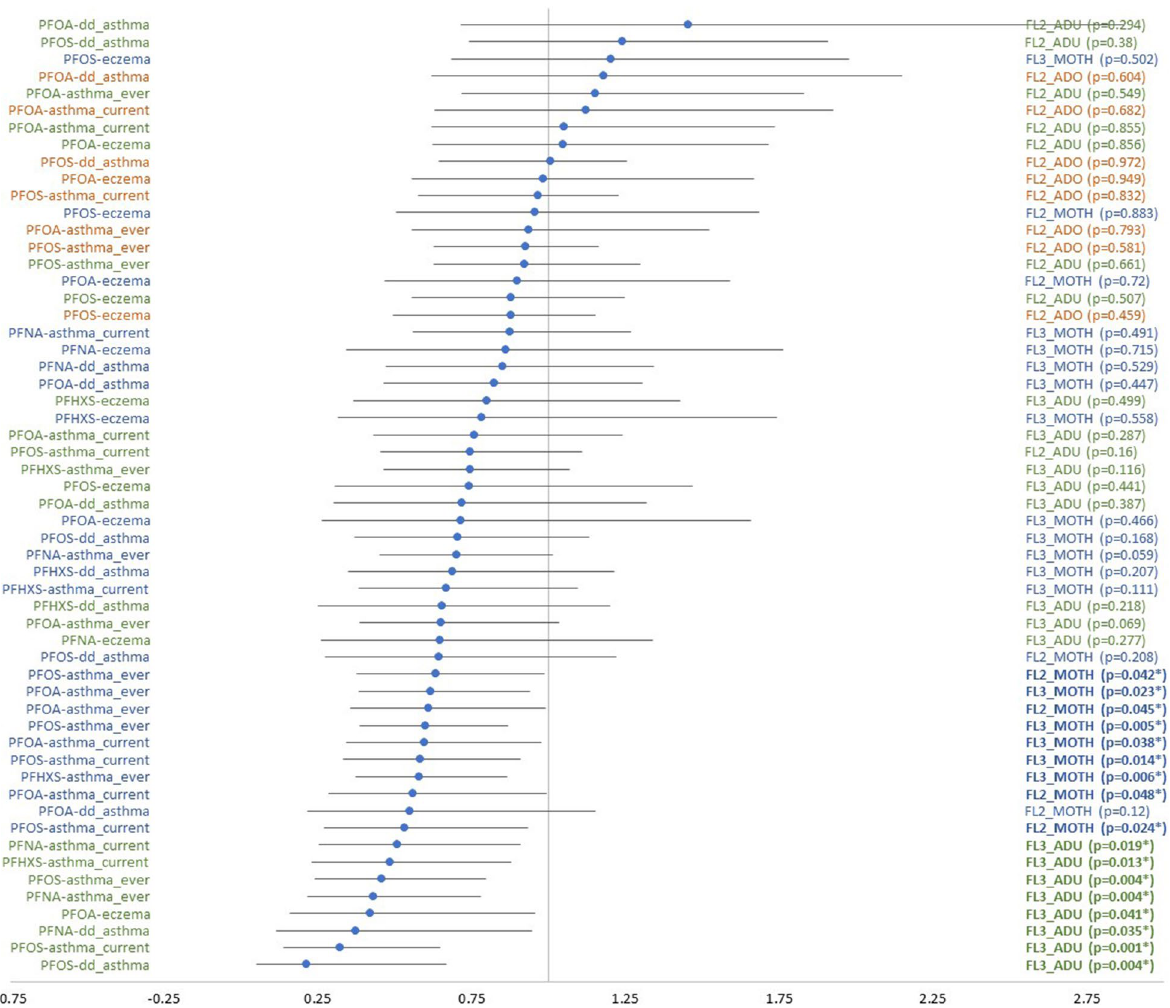
Fig. 2 Forest plot of the odds ratios (ORs) of the asthma outcomes and eczema in relation to the measured PFAS in the different FLEHS studies (with FL2 FLEHS-2, FL3 FLEHS-3, ADO adolescents, ADU adults, MOTH mothers). The OR (95% confidence interval) is expressed for an interquartile increase in exposure . Confounders and covariates that were included at the start of the stepwise multiple regressions are mentioned in Additional file 1: Tables S2, S3, S4, S5 and